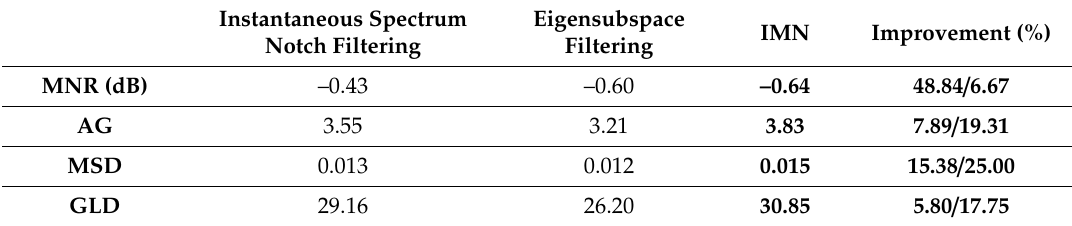
Figure 20. Mitigation results. ( a ) The SAR image without interference mitigation, ( b ) the SAR image after applying the instantaneous-spectrum notch filtering, ( c ) the SAR image after applying the eigensubspace filtering, and ( d ) the SAR image after applying the IMN. Table 7. SAR image quality evaluation for the measured WBI-contaminated data.